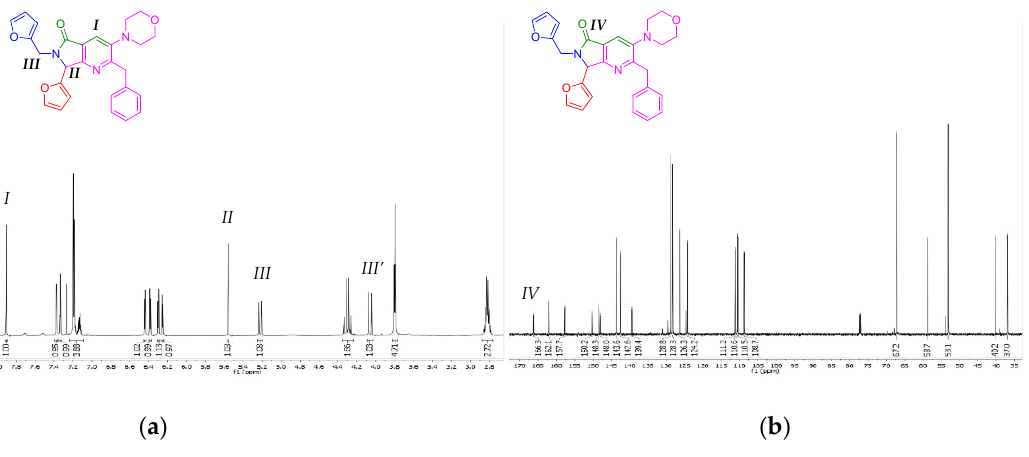
Figure 2. ( a ) 1 H NMR spectrum of the compound 1a , ( b ) 13 C NMR spectrum of the compound 8a .